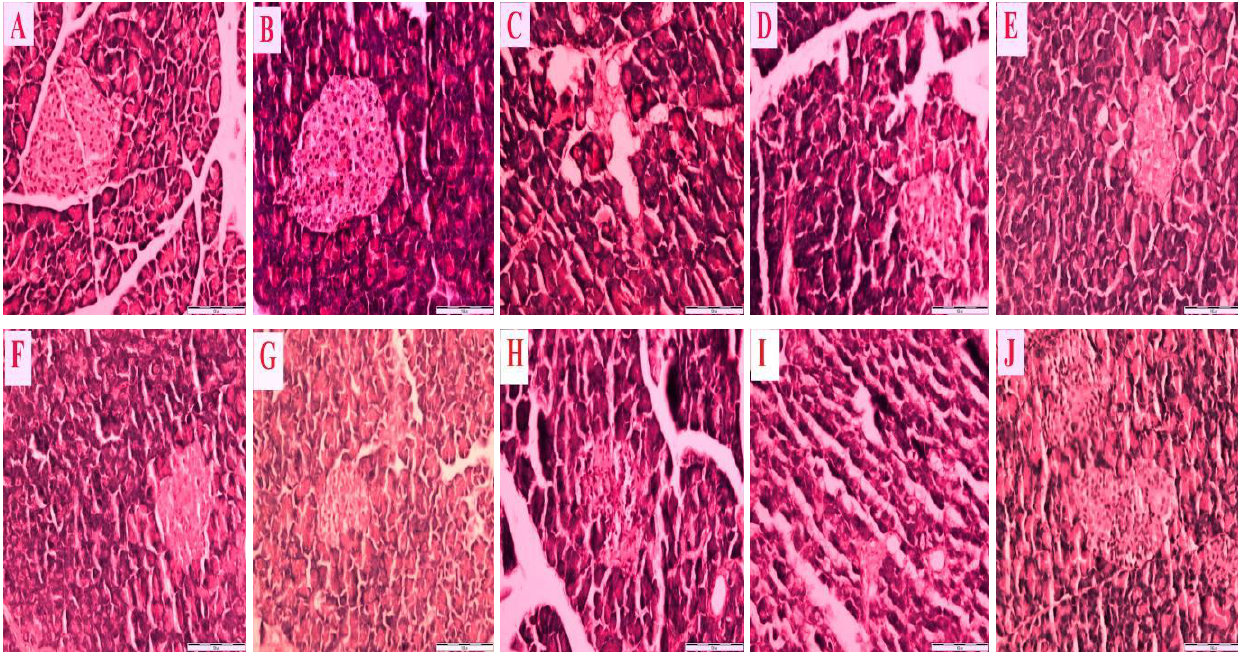
Figure 2. Representative photomicrographs of hematoxylin and eosin staining of pancreas (scale bar: 100 µm) showing non-diabetic control rats treated with distilled water ( A ); non-diabetic rats treated with tualang honey ( B ); diabetic control rats treated with distilled water ( C ); diabetic rats treated with tualang honey ( D ); diabetic rats treated with metformin ( E ); diabetic rats treated with metformin and tualang honey ( F ); diabetic rats treated with glibenclamide ( G ); diabetic rats treated with glibenclamide and tualang honey ( H ); diabetic rats treated with metformin and glibenclamide ( I ); diabetic rats treated with metformin, glibenclamide and tualang honey ( J